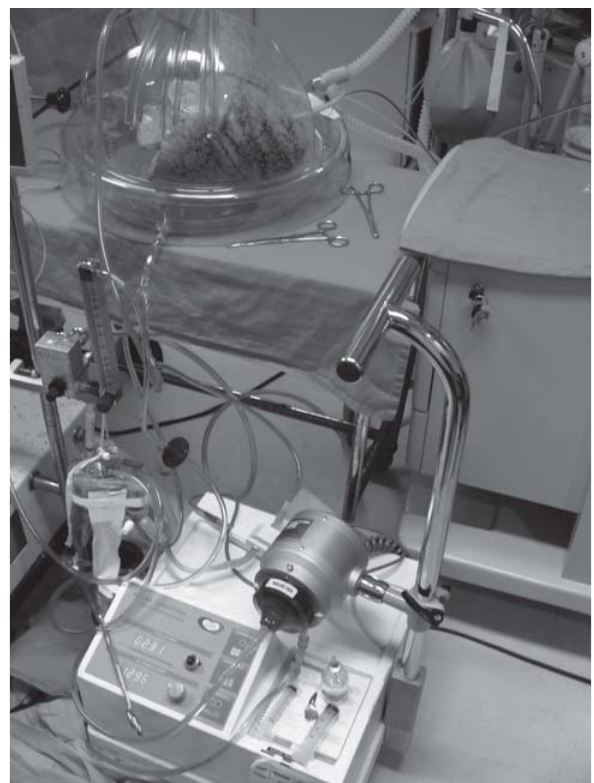
Fig. 1 – Circuito completo com caixa de contenção pulmonar, bomba centrífuga, reservatório e oxigenador de membrana preenchidos com a solução de perfusão (Steen Solution) Usamos como fluxo de perfusão, 40% do débito cardíaco (DC) estimado (DC = 3 X área de superfície corpórea). Iniciamos a PPEV com a solução na temperatura de 20ºC e um fluxo inicial de 10% do calculado. A temperatura é gradualmente elevada até 37ºC nos primeiros 30 minutos. O fluxo também sobe lentamente, atingindo 30% do calculado em 30 minutos, e alcançando o fluxo máximo por volta de